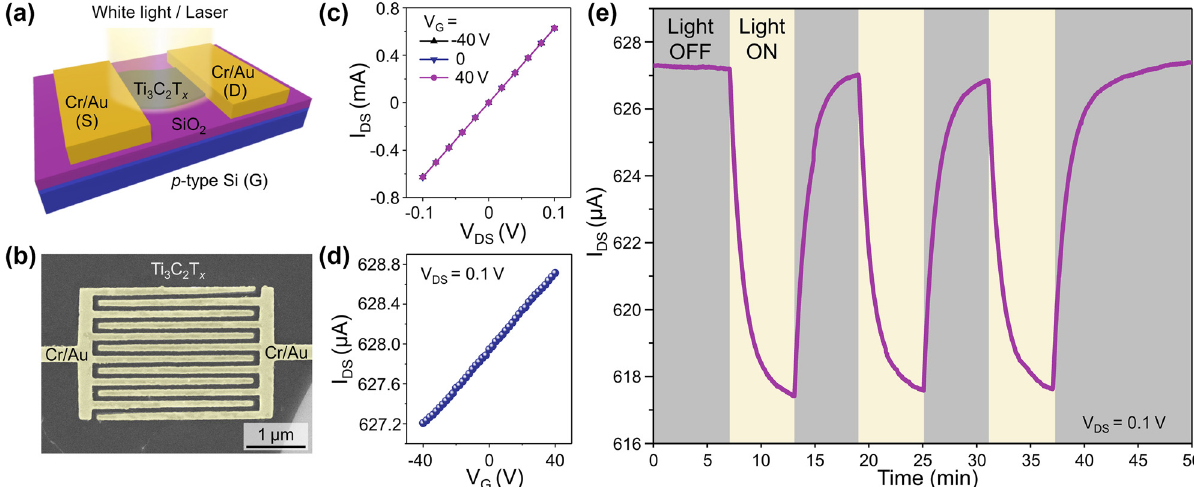
C T flakes to white light. (a) Scheme of a two-terminal Ti 3 2 x C T MXene flake. The electrodes are colored in yellow 3 2 x C T device shown in (b) at the gate voltages of − 40, 0, and 3 2 x = 0.1 V. (e) Negative photoresponse of the same device to white light, DS